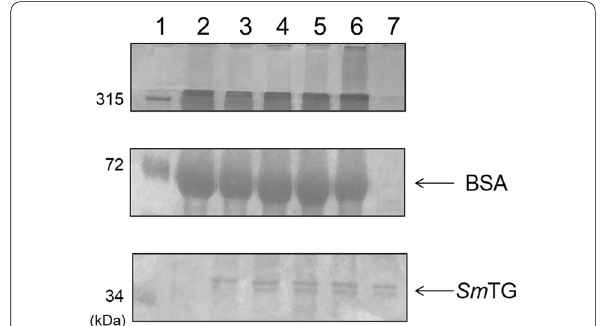
Fig. 1 Cross‑linking assay using BSA as a substrate after incubation with a Sm TG solution extracted from the BY4741‑TG strain for several reaction times. Lane 1, molecular size marker; lane 2, BSA; lanes 3, 4, 5 and 6, 1 Sm TG ( BSA) for 0, 30, 60 and 120 min, respectively; lane 7, × + 1 Sm TG ( × −